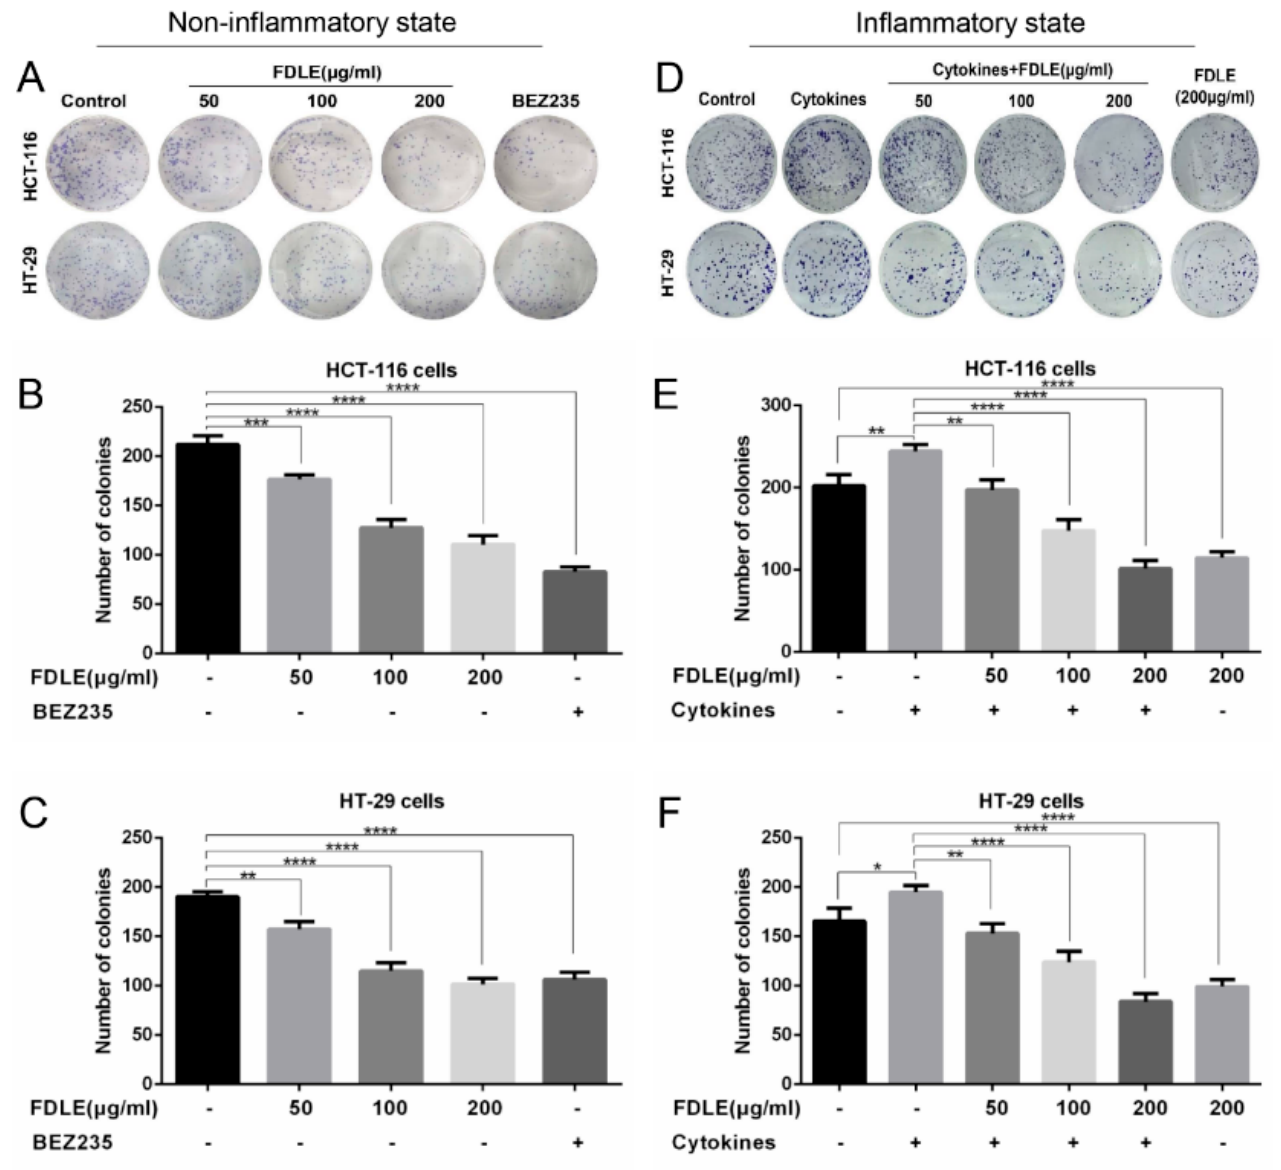
Figure 3. The effects of FDLE on growth inhibition in non-inflammatory and inflammatory HCT- 116 and HT-29 colorectal cancer cells by colony formation assay. ( A – C ) Colony number of non-inflammatory HCT-116 and HT-29 cells treated with three doses (50, 100 and 200 µg/mL) of FDLE for 48 h. ( D – F ) Colony number of inflammatory HCT-116 and HT-29 cells treated with three doses (50, 100 and 200 µg/mL) of FDLE for 48 h after adding a mixture of cytokines (TNF- α , IFN- γ and LPS each 10 ng/mL) for 2 h. The cells were washed by PBS and cultured for 7 days. The results were represented as mean ± SD of three independent experiments, * p < 0.05, ** p < 0.01, *** p < 0.001, **** p < 0.0001 .